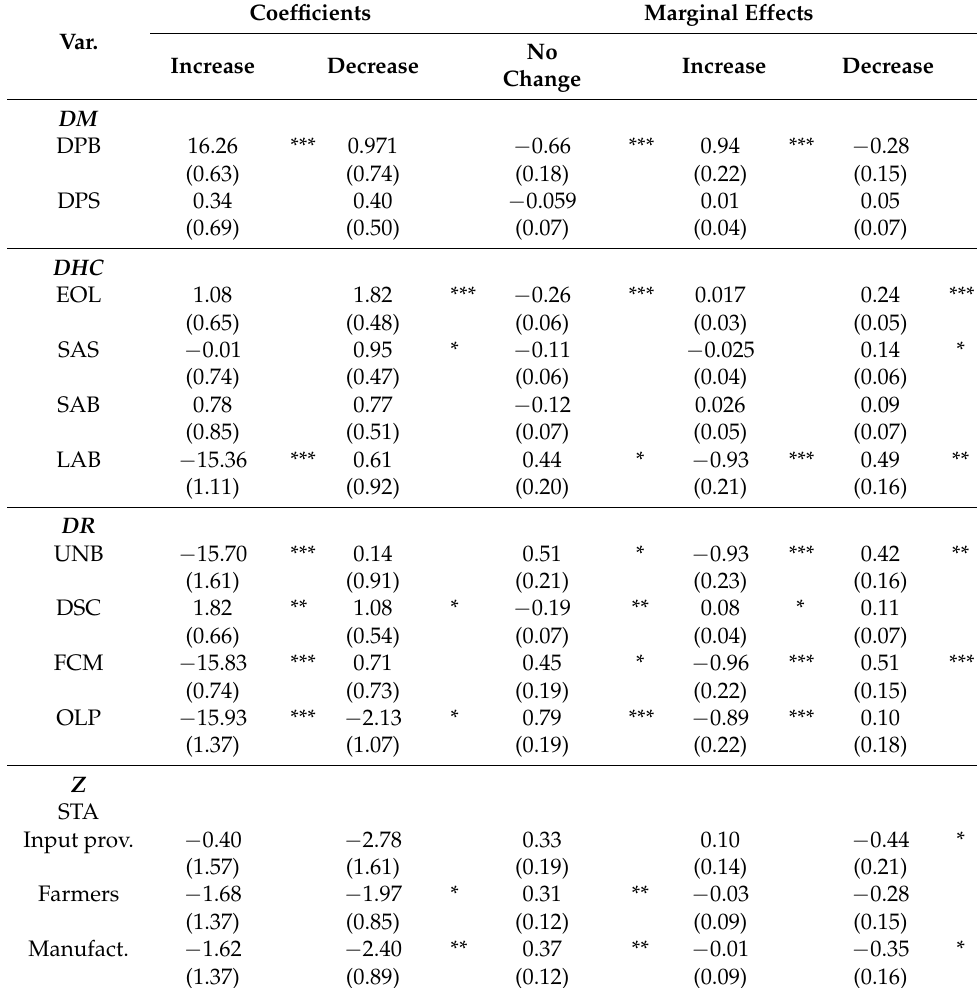
Table 4. Regression